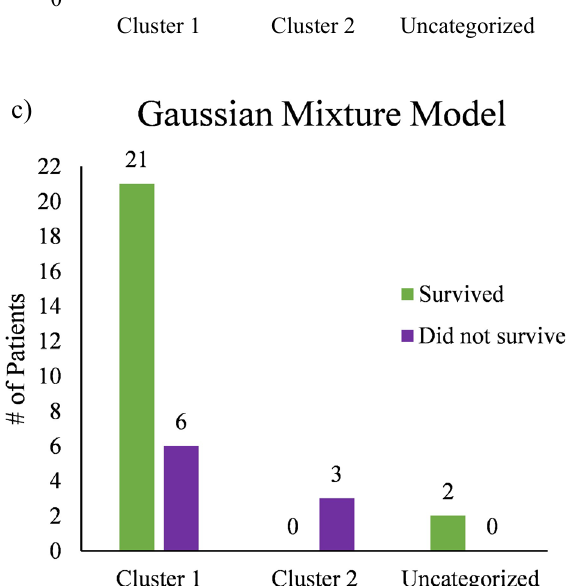
Figure 4. Cluster-Patient groupings (n = 32) using the majority-vote approach as determined by the three unsupervised clustering model. ( a ) K-means; ( b ) Fuzzy C-means; ( c ) Gaussian Mixture model. Green represents patients which survived after 5-years (n = 23) whereas purple denotes patients which did not (n = 9). Of note is the composition of Cluster 1 across all models, being primarily comprised of 5-year survivors (for details, see